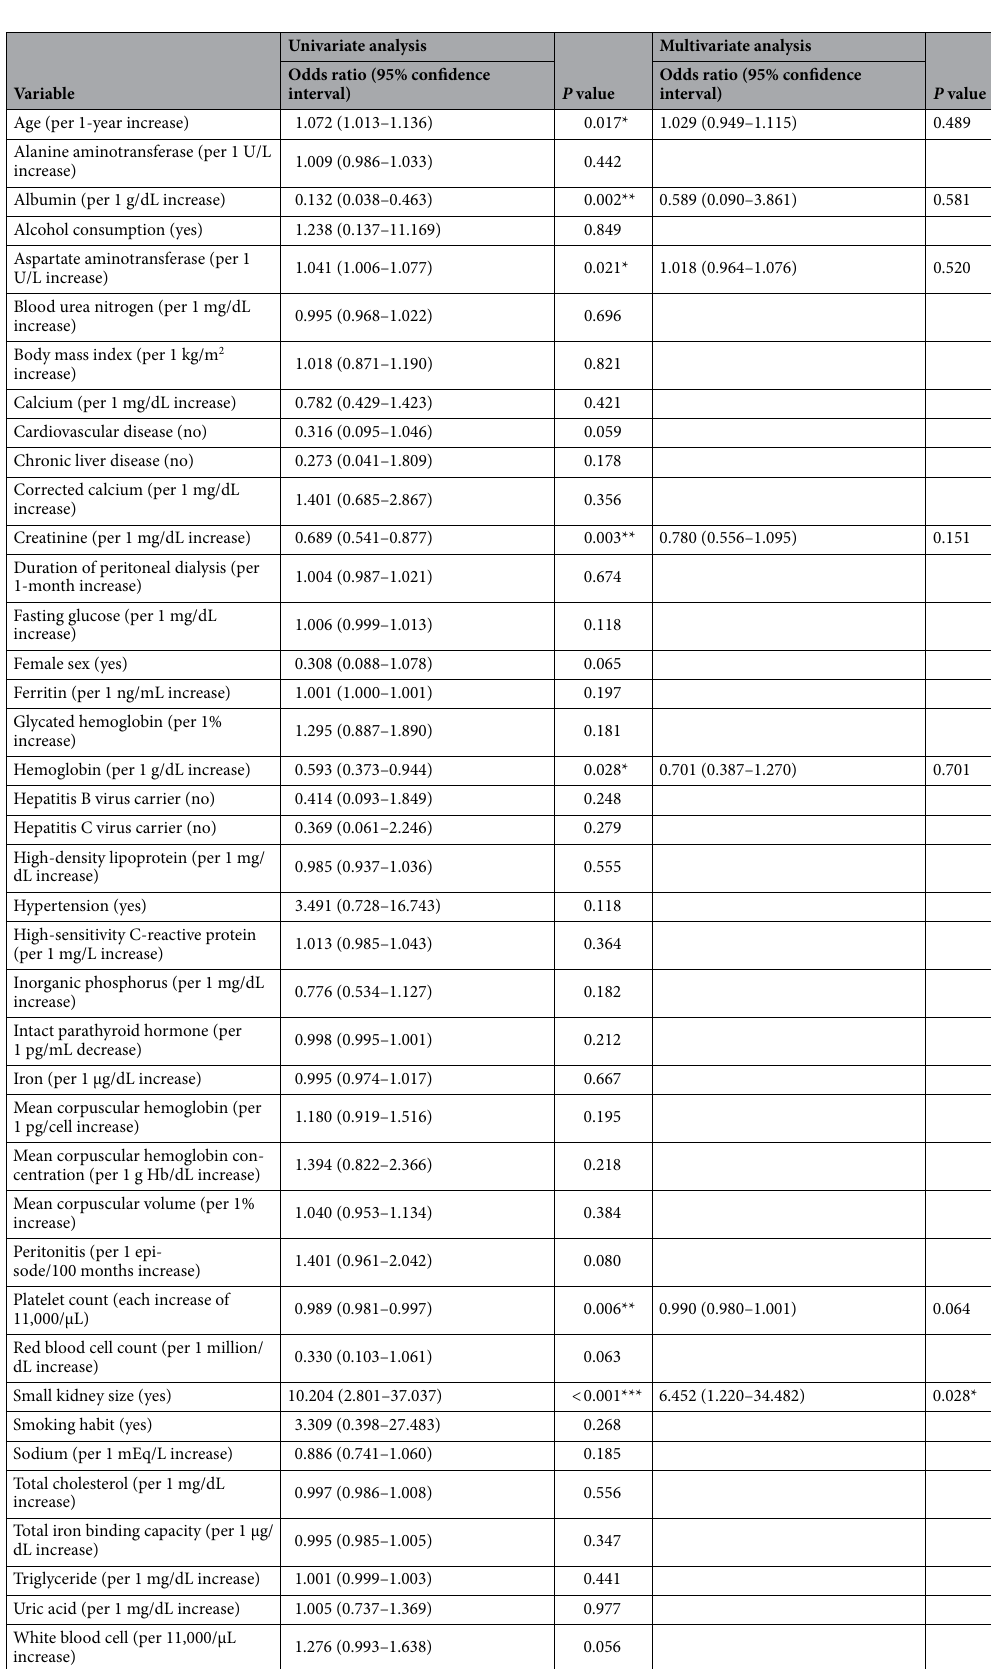
Table 5. Analysis of mortality using a multivariate logistic regression model (n = 83). * P < 0.05; ** P < 0.01; * P <